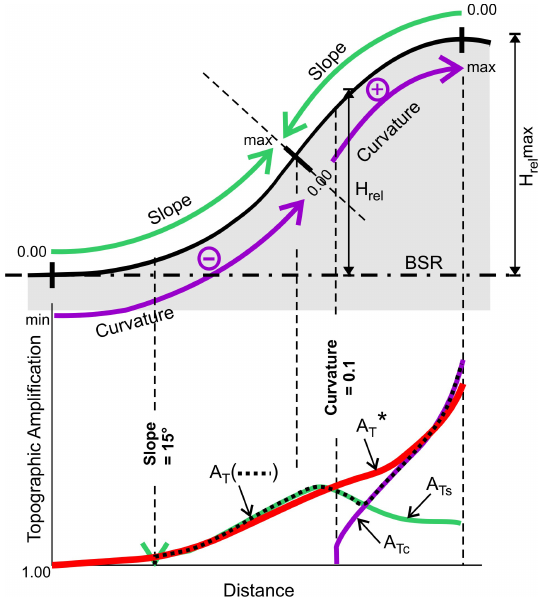
Figure 10. The behaviour components of the topographic amplifi- cation model in relation to the distribution of the GIS-topographic attributes (DEM, slope, and curvature) along an isolated